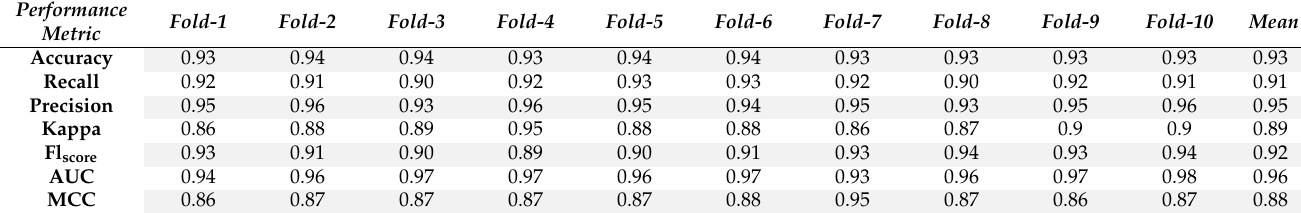
Table 3. The 10-fold cross-validation results for the proposed